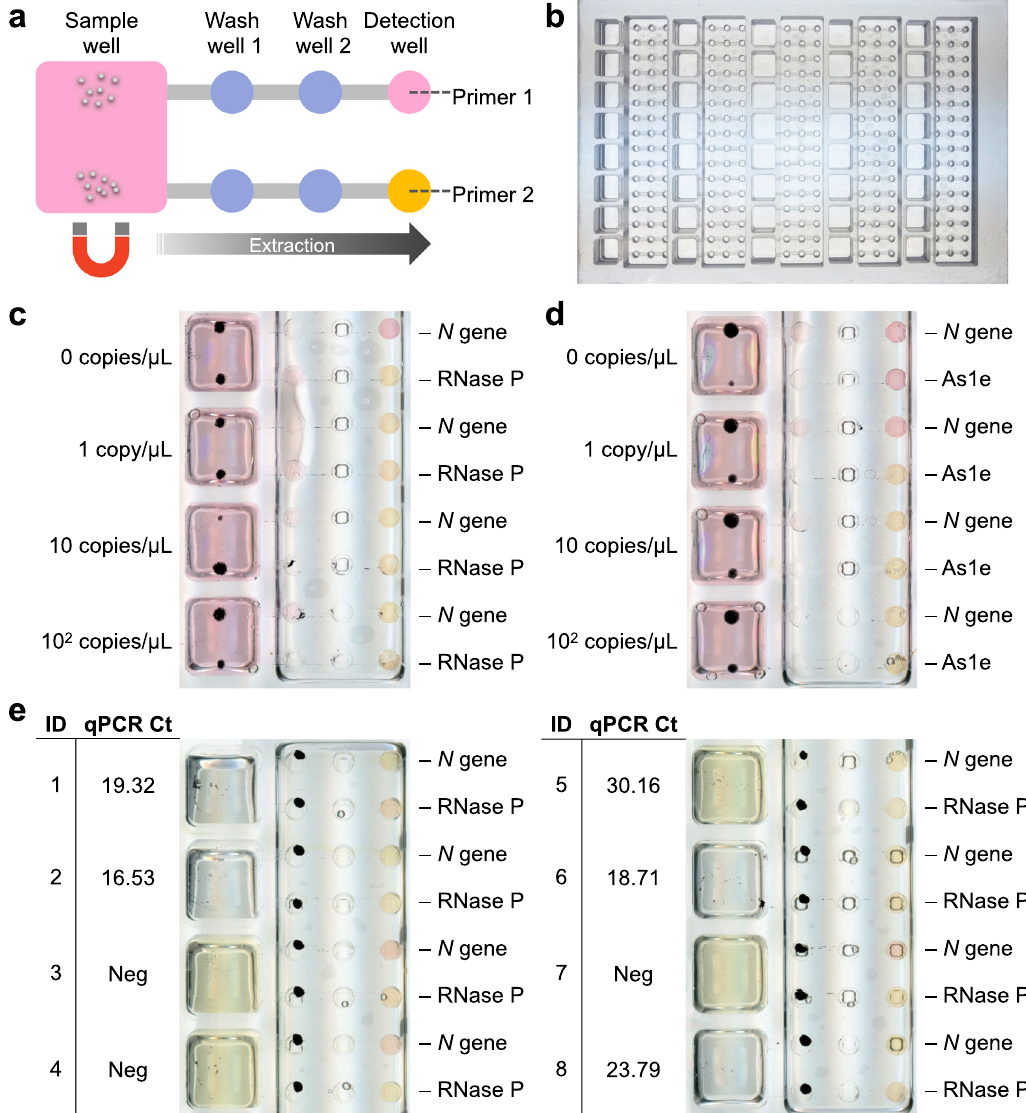
Fig. 6 Dual output OIL-TAS device enables simultaneous multiplexed detection from a single sample. a OIL-TAS can be designed with multiple extraction outputs (two outputs shown here) leading from a single input sample well, enabling multiplexed detection of a sample by using different primers in the detection well. b Image of the dual-output OIL-TAS device which has the same footprint as a 96-well plate (127.76 mm × 85.48 mm). c Multiplexed detection of the SARS-CoV-2 N gene with an extraction positive control (RNase P). γ -irradiated inactivated SARS-CoV-2 particles were spiked into a cell suspension containing 10 A549 cells/ µ L in VTM to mimic a clinical sample. d Multiplexed detection of two different regions of the SARS-CoV-2 genome (As1e, which targets the open-reading frame ( ORF1a ), and the N gene). e Multiplexed detection of the N gene and RNase P on clinical NP swab samples 1 – 8 (from Supplementary Table